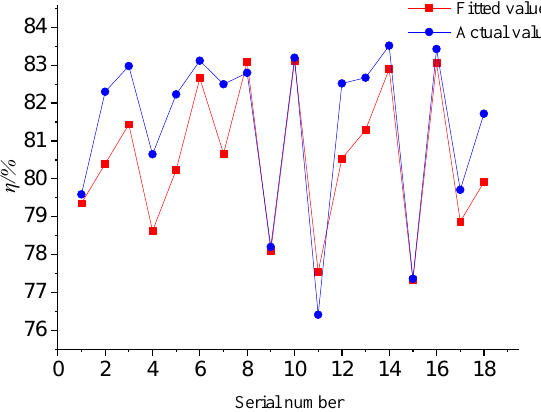
Figure 3. Comparison of fitted value and actual value for efficiency .